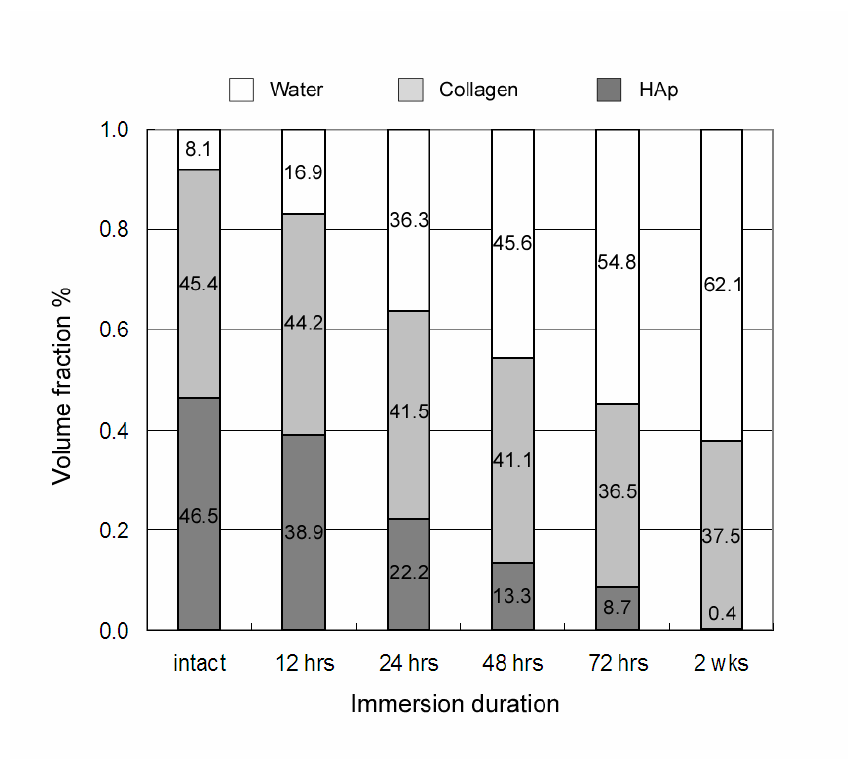
Fig. 3 Changes in volume fraction of each structural constituents (HAp, collagen and water) after gradual demineralization. The volume fraction of each structural constituent in the specimens was calculated from X-ray absorption characteristics and quantifying transmitted X-ray